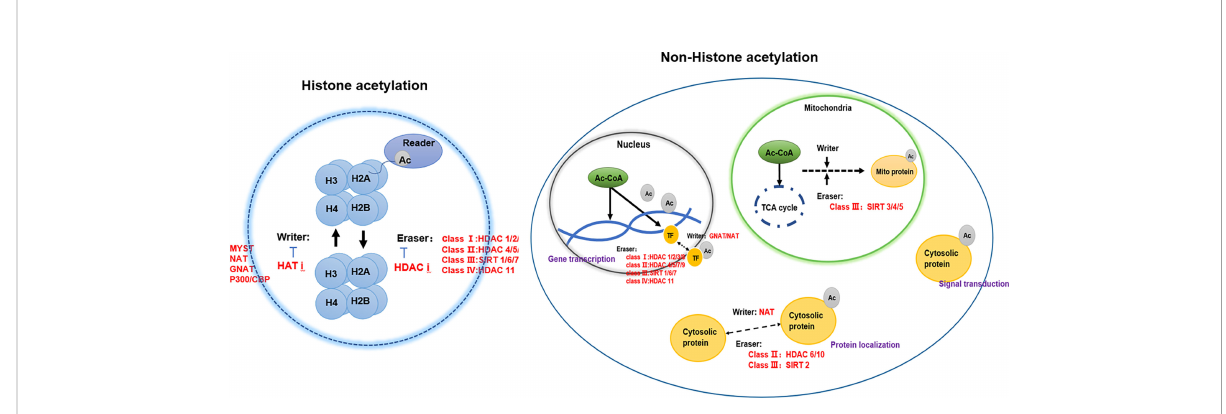
FIGURE 1 The regulators of protein acetylation-writers, erasers, and